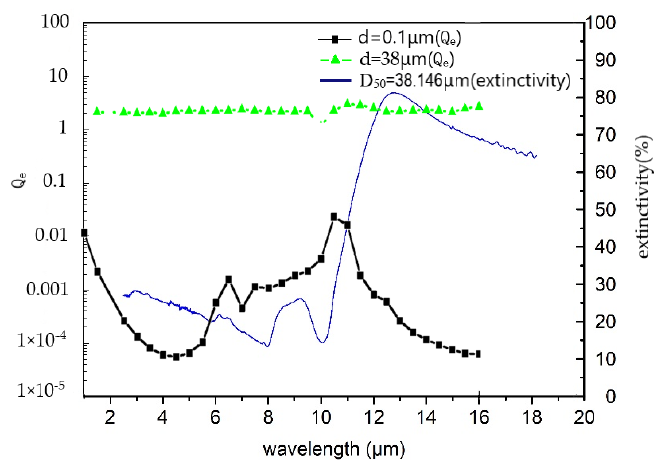
Figure 16. Comparison between the simulation results of the extinction performance of the SiC elementary particles with two particle sizes and the test results of SiC sample #2.